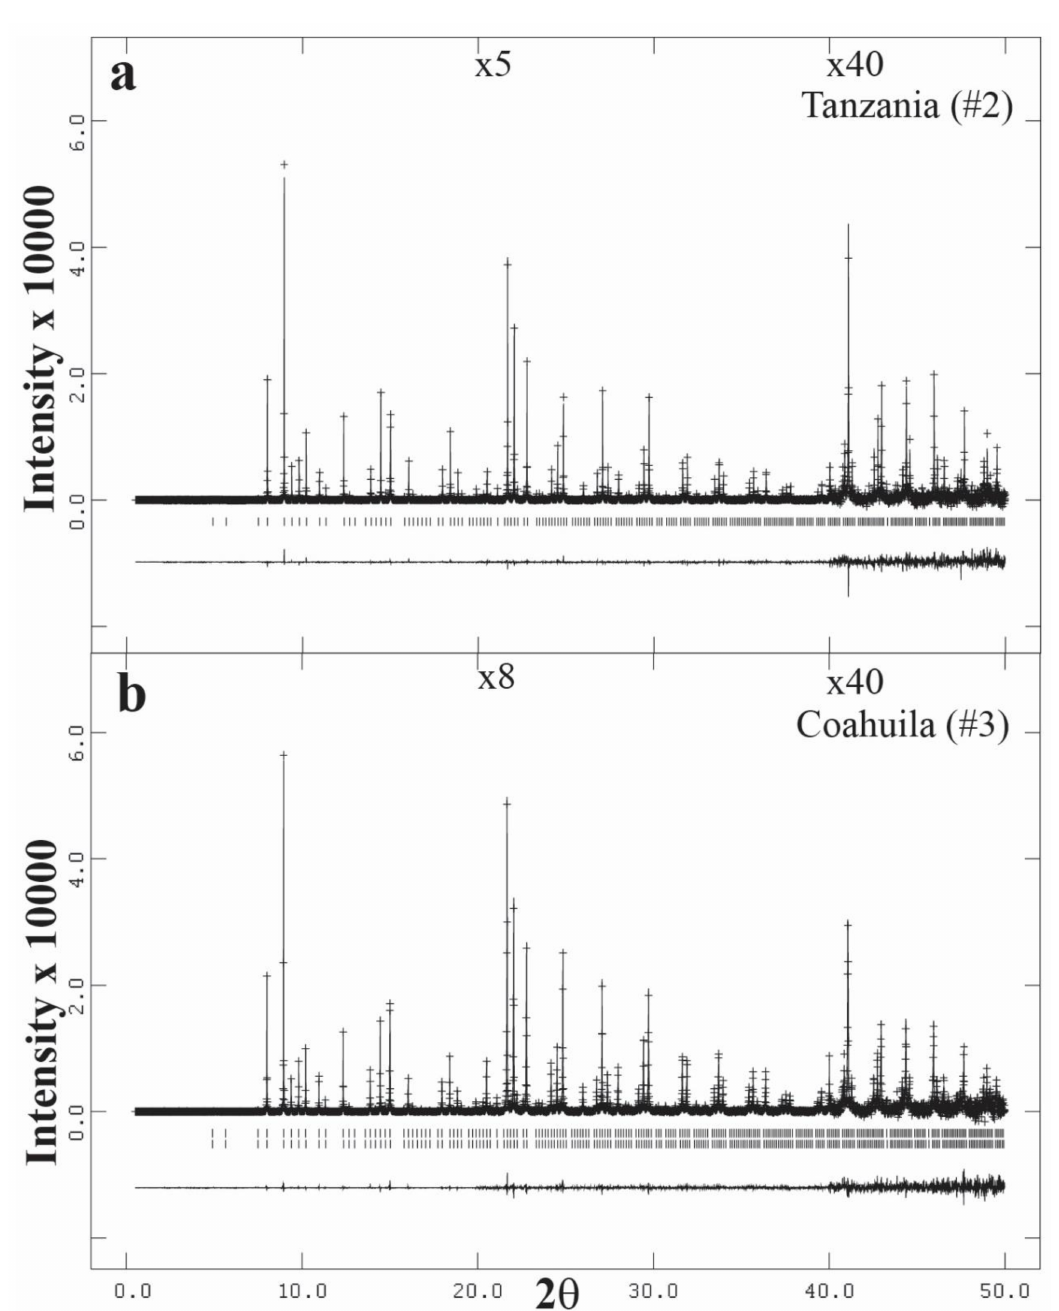
Figure 12. Complete HRPXRD traces for the grossular samples from ( a ) Tanzania (sample-2) and ( b ) Coahuilla, Mexico (sample-3). Data for sample-3 was modelled using two slightly different cubic phases, whereas sample-2 was modelled with a single cubic